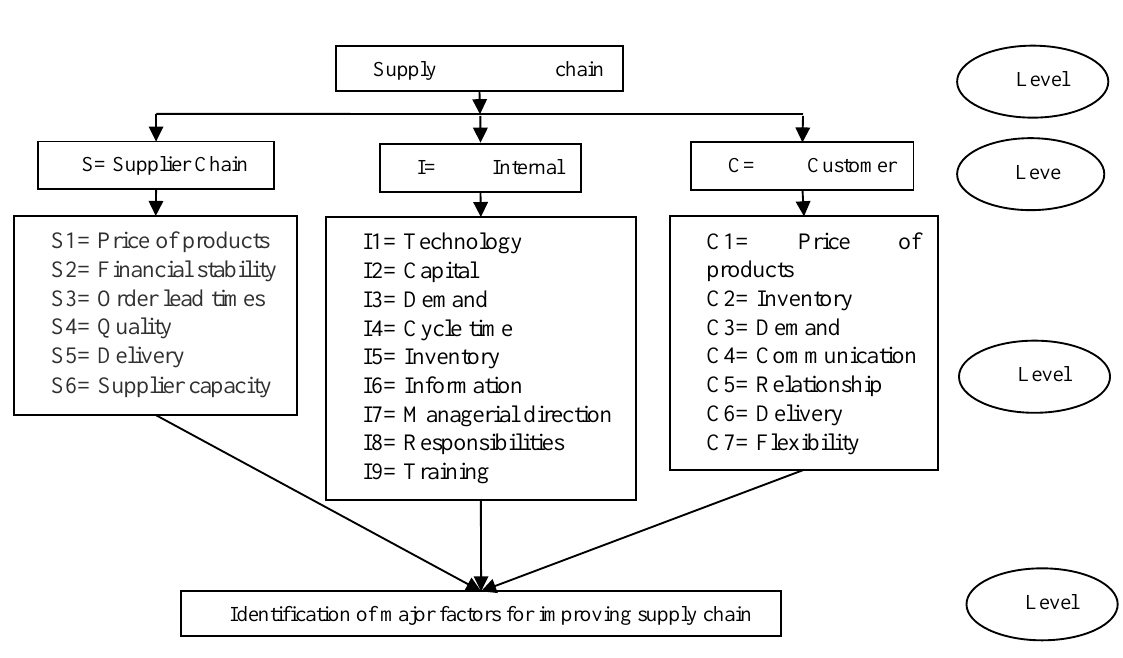
Figure 2. AHP framework for identifying major effected